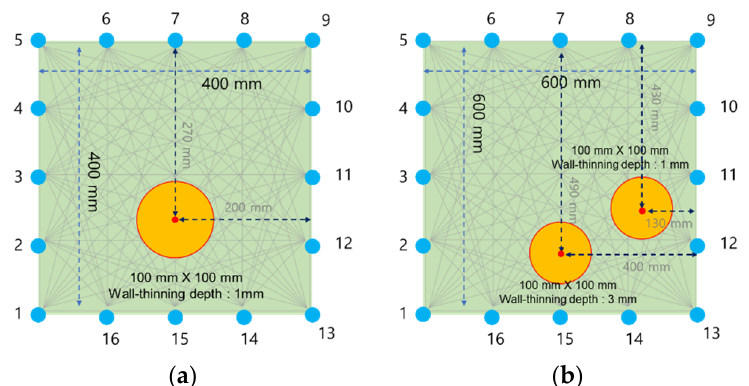
Figure 4. Specimen information: ( a ) single defect and ( b ) multiple defects.